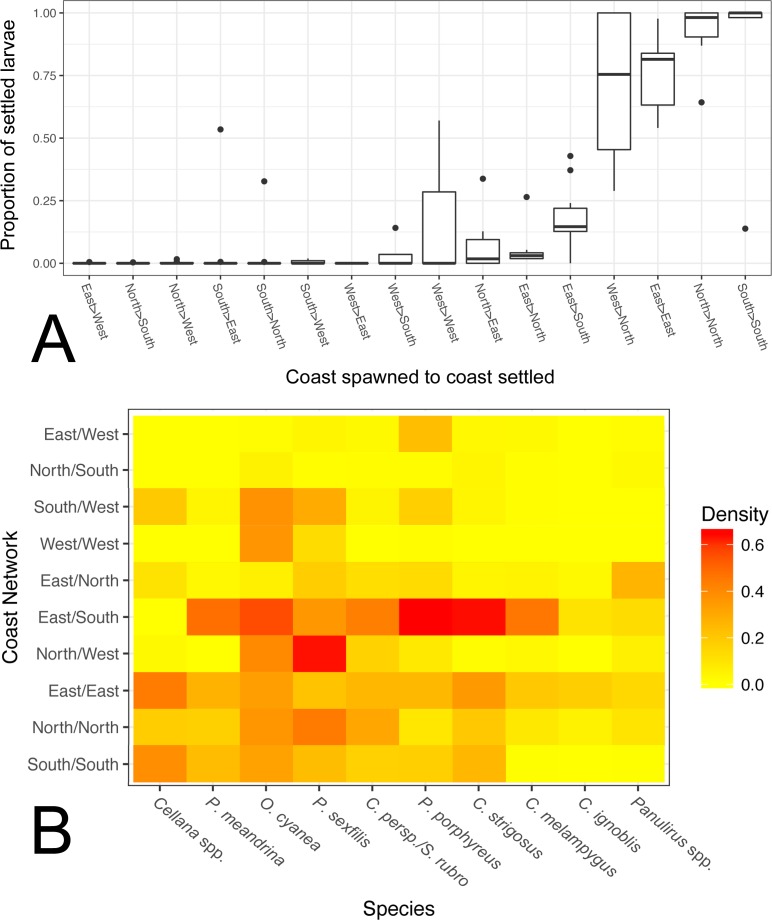
Coast-by-coast patterns of connectivity on Moloka‘i.(A) Average rearward settlement proportion by species per pair of coastlines, calculated by the number of larvae settling at site s from site o divided by all settled larvae at site s. Directional coastline pairs (Spawn > Settlement) are ordered from left to right by increasing median settlement proportion. (B) Heatmap of edge density for coast-specific networks by species. Density is calculated by the number of all realized paths out of total possible paths, disregarding directionality.